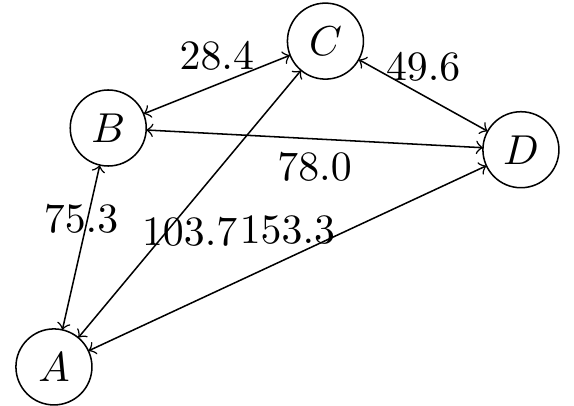
Figure 14. Relative distance development of satellites since launch.